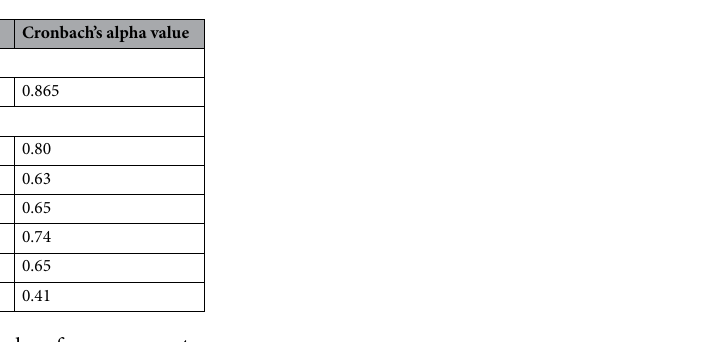
Table 3. Cronbach’s alpha values for